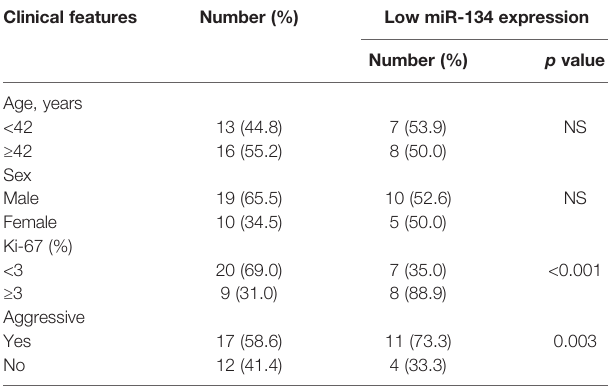
TABLE 1 | The correlation between clinical features of NF-PitNETs and the expression of miR-134. Clinical